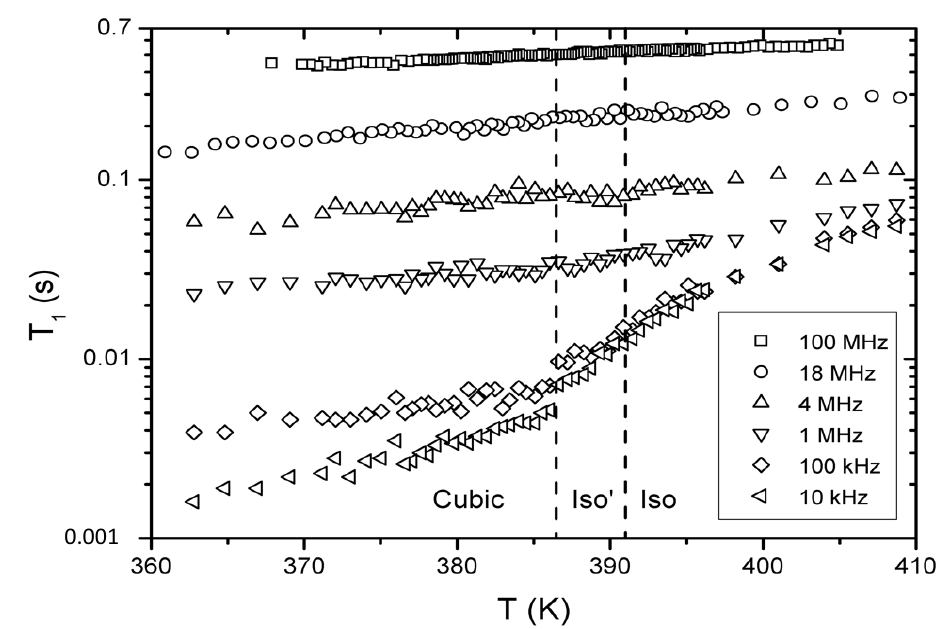
Figure 4. Temperature dependence of proton spin-lattice relaxation time of L1 at some chosen Larmor frequencies. Vertical dashed lines indicate the phase transition temperatures.